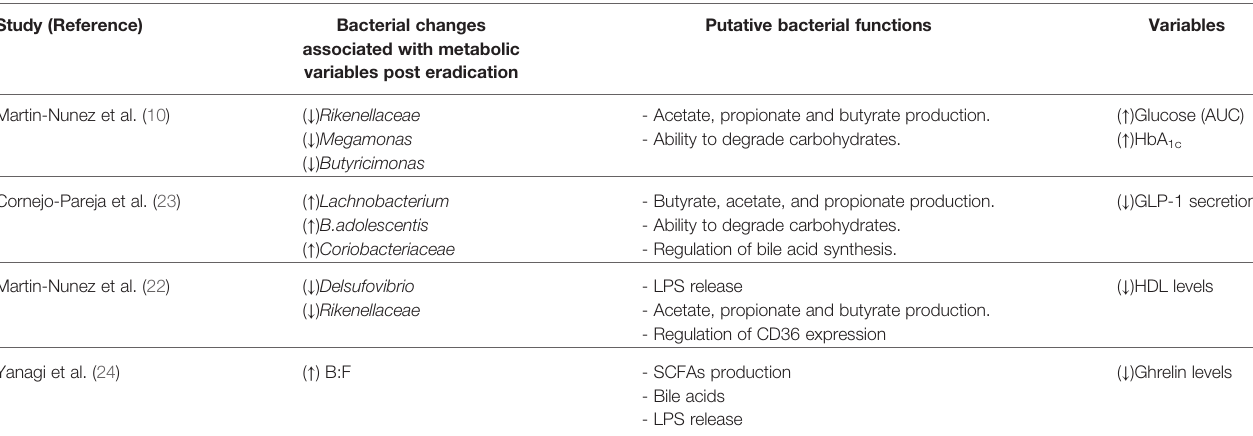
TABLE 3 | Relationships between H. pylori eradication therapy-induced bacterial changes and metabolic variables. Study (Reference) Bacterial changes Putative bacterial associated with metabolic variables post eradication